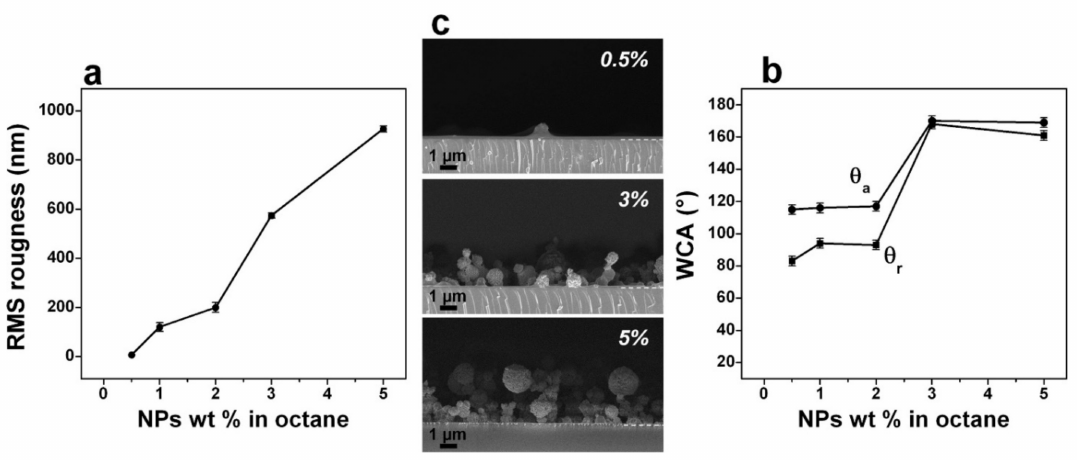
Figure 12. ( a ) RMS roughness of the nanocomposite coatings as a function of the concentration of oleate-capped ZnO NPs in the aerosol suspension. ( b ) Corresponding advancing and receding water contact angle (WCA) for 10 min deposition time. ( c ) Cross-sectional SEM images of nanocomposite (NC) films deposited from dispersions at di ff erent concentration of the oleate-capped ZnO NPs in n-octane (0.5, 3, and 5 wt%). Reprinted with permission from [57]. Copyright 2014 American Chemical